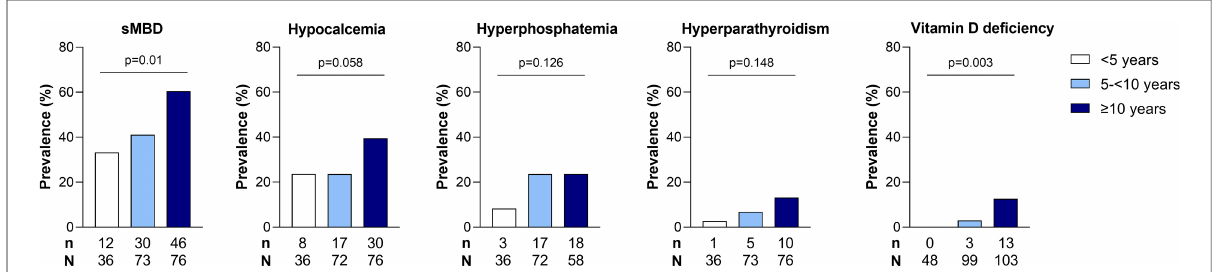
FIGURE 2 Relationship between age and sMBD in children with SCA. Bar graph depicting the frequency of sMBD prevalence and individual mineral abnormalities across age categories (<5 years, 5- <10 years, ≥ 10 years). Differences in the frequency of sMBD and mineral abnormalities assessed using Pearson ’ s chi-square test or Fisher ’ s exact test, as appropriate. The p values are presented on the bar